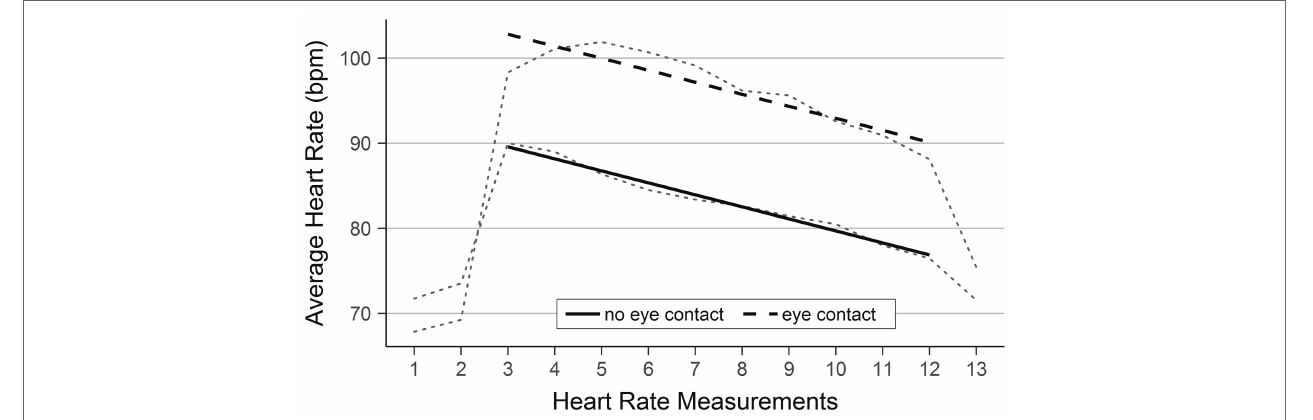
FIGURE 2 | Fitted regression lines of heart rate in the two conditions over time. The figure shows the heart rate predicted by the regression. The bold, solid line shows the prediction for the no eye contact condition and the bold, dashed line shows the prediction for the eye contact condition. The model includes all measurements taken during the reading of insults (three through 12). The light, dotted lines in the background show the observed development of the average heart rates (cf. Figure 1